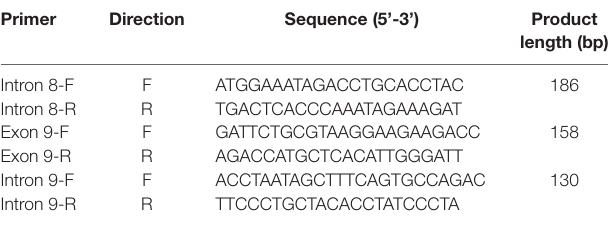
TABLE 2 | Quantitative PCR (qPCR)